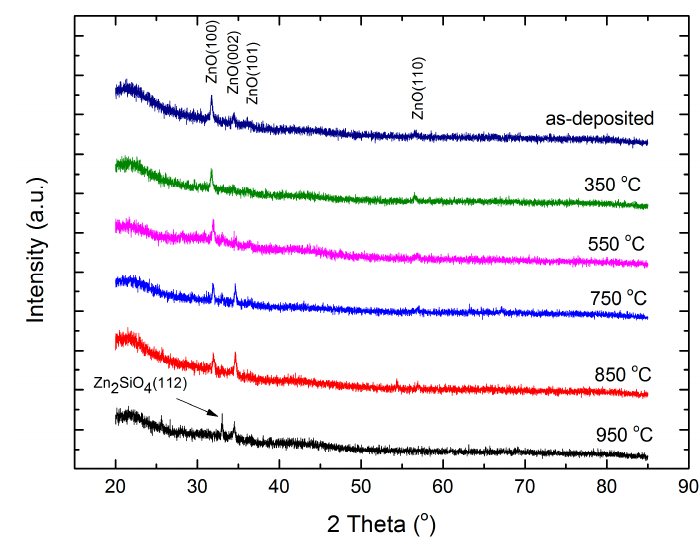
Figure 1. X-ray diffraction (XRD) pattern of ZnO:Zr thin films annealed at different temperatures.